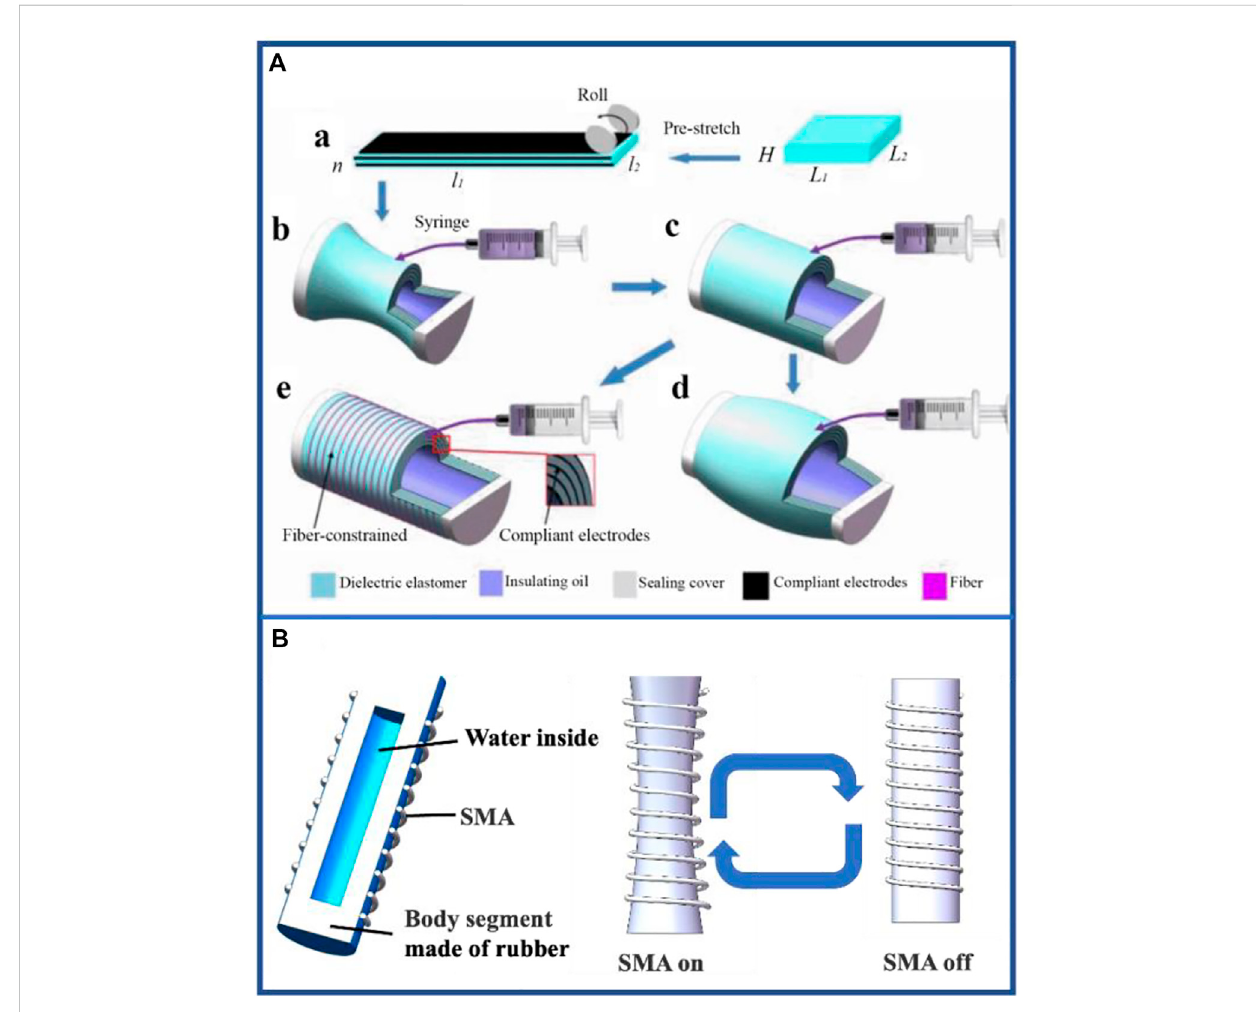
FIGURE 5 Basic principle and examples of hydraulic-driven single-segment earthworm-inspired soft robot. (A) Conceptual fabrication process and structural expansion during liquid injection. Two pieces of a DE membrane with the same designed pre-stretch ratio are stacked with three coats of compliant electrode alternatively and then rolled into a DE tube with two caps (a). With the injection of insulating oil, the DE tube will go through three stages: shrinking stage (b), cylinder stage (c) and bulging stage (d). However, when the cylinder DE tube is constrained in the circumferential direction, the DE tube will maintain a cylinder shape and elongate to the design goal (e). Reproduced from Ref. Wang et al. (2018a) with permission. (B) Operation diagram of SMA actuating hydraulic